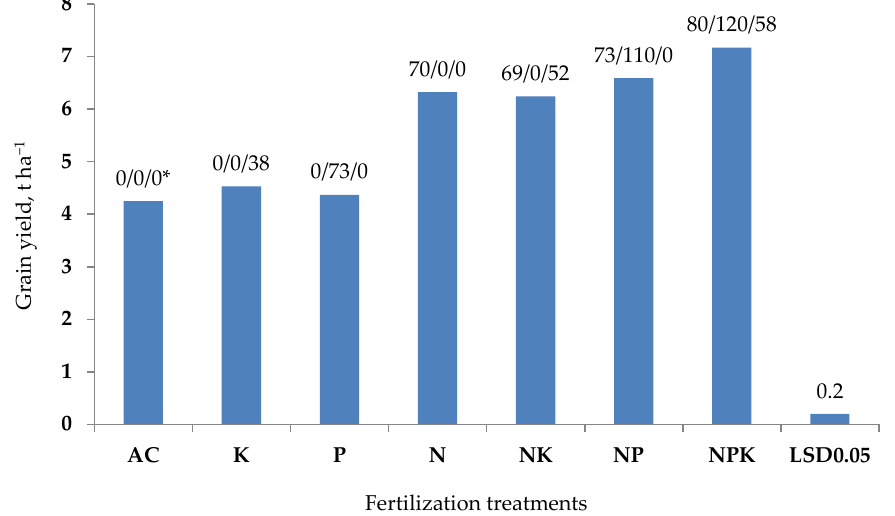
Figure 2. Effect of long-term differentiated fertilization on yield of winter wheat, mean of 2005–2008 years (own projection based on Blecharczyk et al. [17]). Key: AC—absolute control; K, P, N—experimental trials since 1957; LSD 0.05 —Least Significant Difference; 0/0/0*—respective values of nitrogen, phosphorus, and potassium use efficiency.